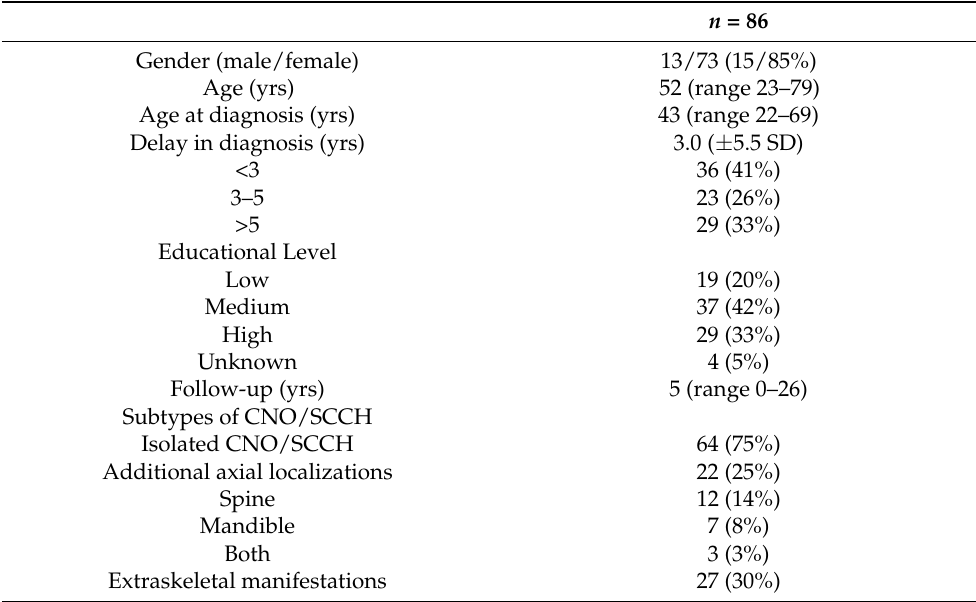
Table 1. Patient characteristics of adult patients with chronic non-bacterial osteomyelitis of the sternocostoclavicular region